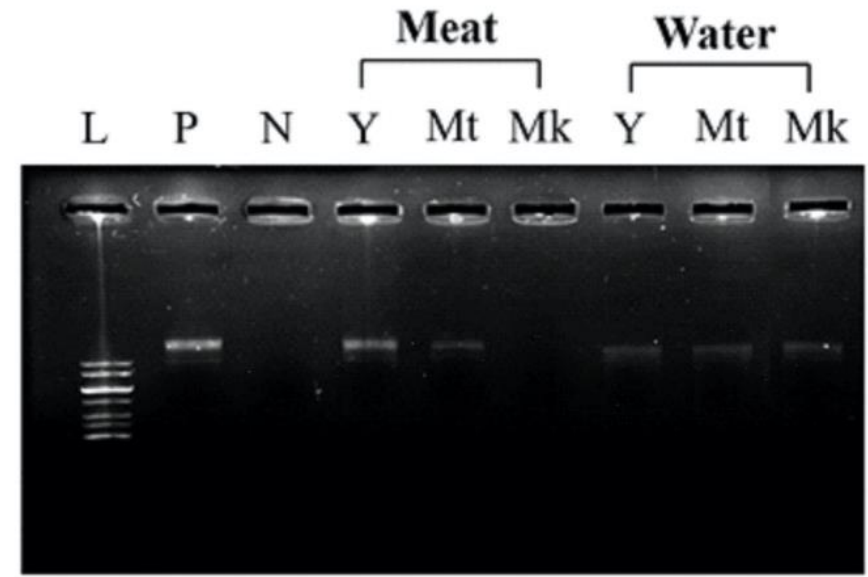
Figure 9. DNA damage protection assay. Lane 1: 1 kb DNA maker (1 kb); Lane 2: pET28a(+); Lane 3: